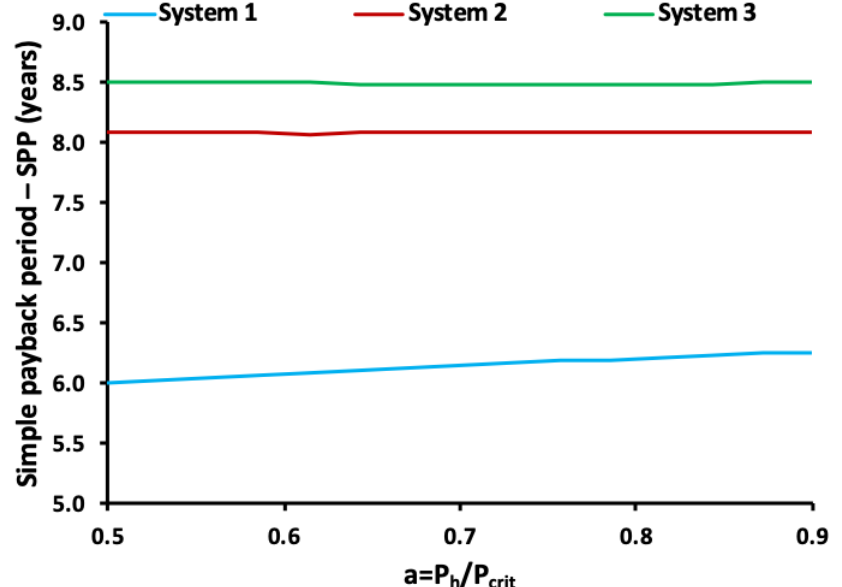
Figure 6. Simple payback period for the three systems with different values of the pressure ratio parameter.